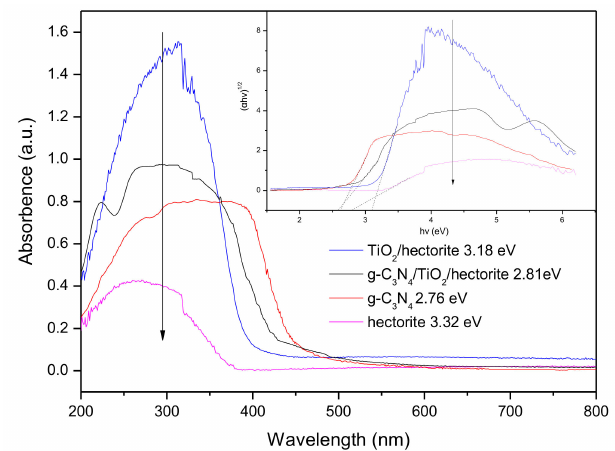
Figure 4. Ultraviolet–visible (UV–Vis) di ff uses reflectance absorbance spectra and band gaps of hectorite, TiO 2 / hectorite, g-C 3 N 4 / TiO 2 / hectorite and g-C 3 N 4 .